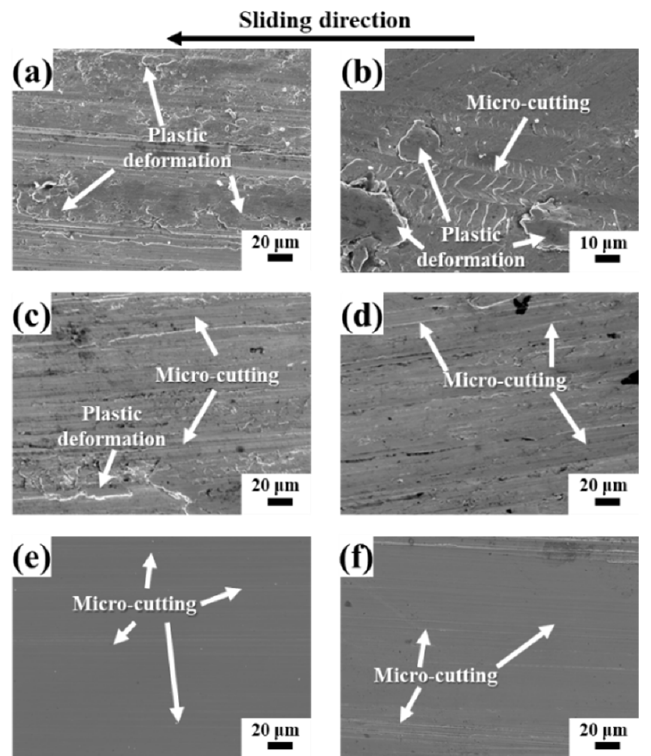
Figure 4. Scanning electron microscopy (SEM) micrographs of wear tracks on AISI304 blocks at rotation speeds of ( a ) 100 and ( b ) 300 rpm, obtained from tests under dry conditions, rotation speeds of ( c ) 100 and ( d ) 300 rpm, obtained from tests under water-lubricated conditions, and rotation speeds of ( e ) 100 and ( f ) 300 rpm, obtained from tests under oil-lubricated conditions.